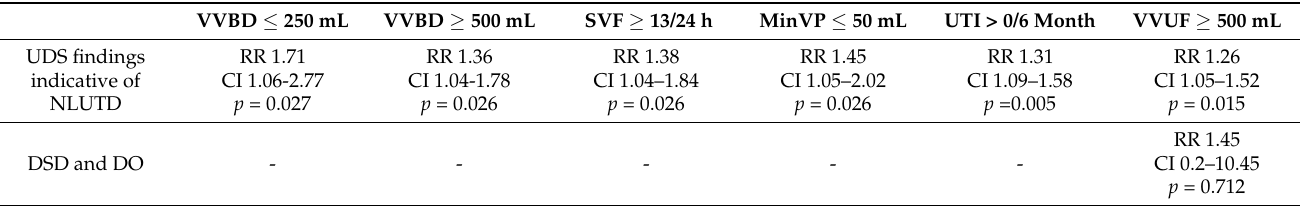
Table 4. Correlations between the clinical parameters and the UDS findings indicative of NLUTD or risk factors of